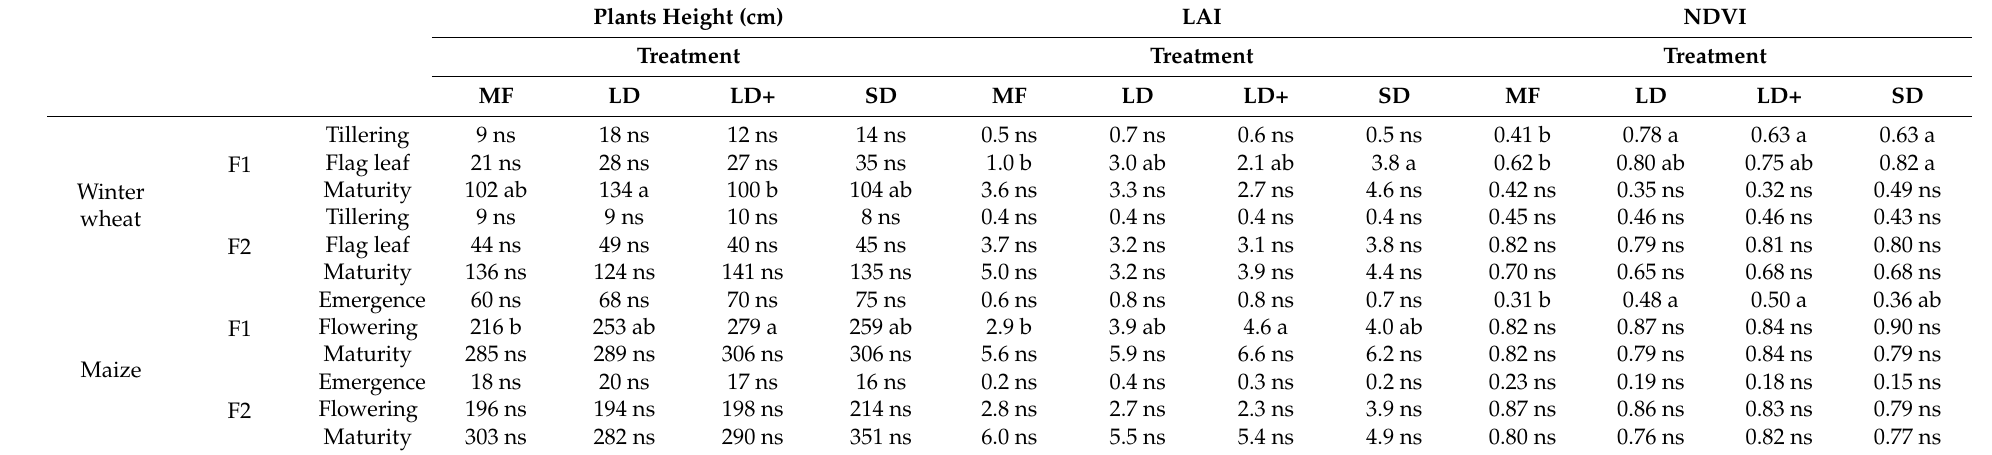
Table 5. Crop trait results (plants height, leaf area index (LAI), and normalized difference vegetation index (NDVI)) for both farms (F1 and F2) and crops (winter wheat and maize). Different letters identified significant differences among treatments according to the Tukey test at p ≤ 0.05. ns = not